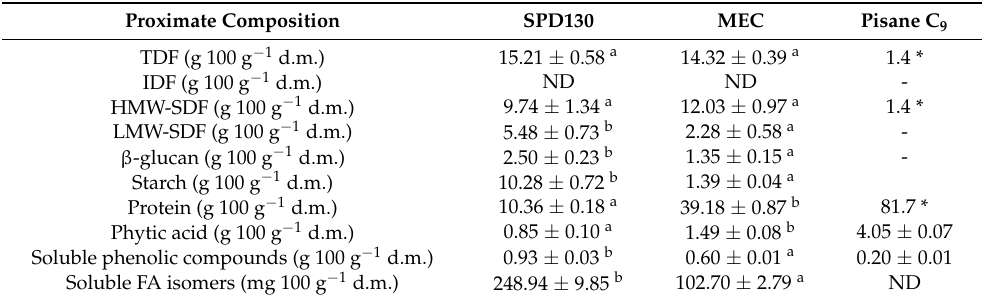
Table 6. Proximate composition of powdered WB hydrolysates obtained using SPD at 130 ◦ C. Proximate Composition SPD130 MEC